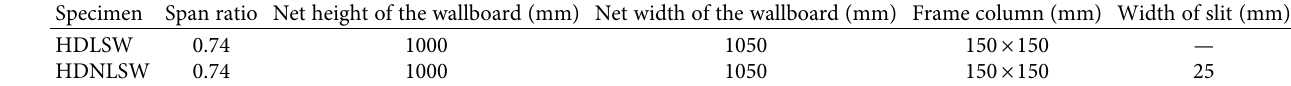
Table 1: Parameters of specimens.